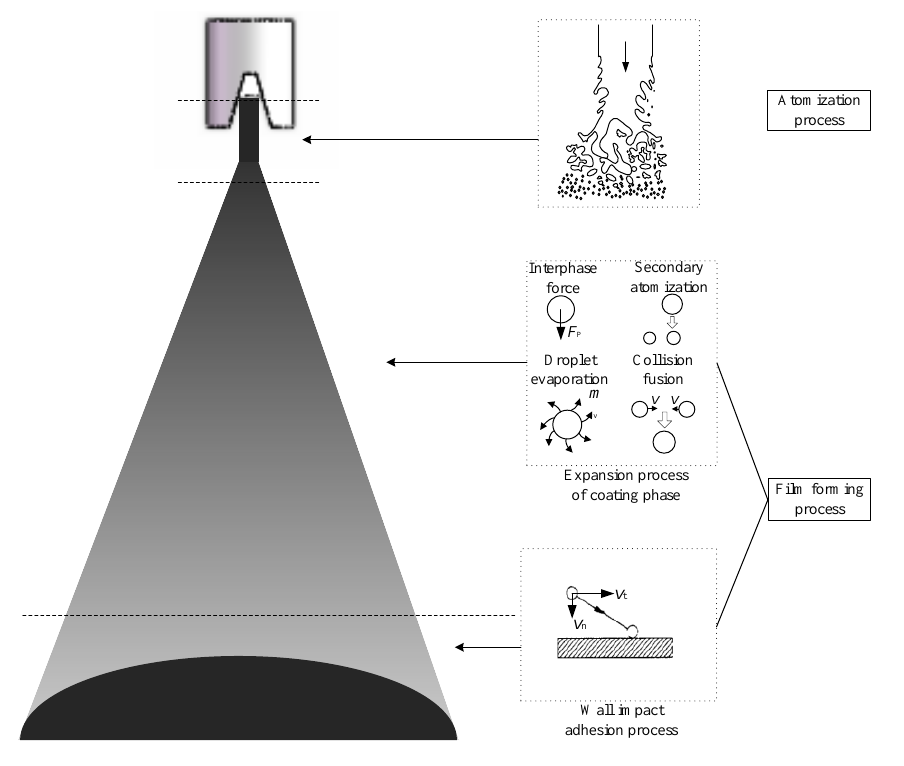
Figure 1. Airless spraying process